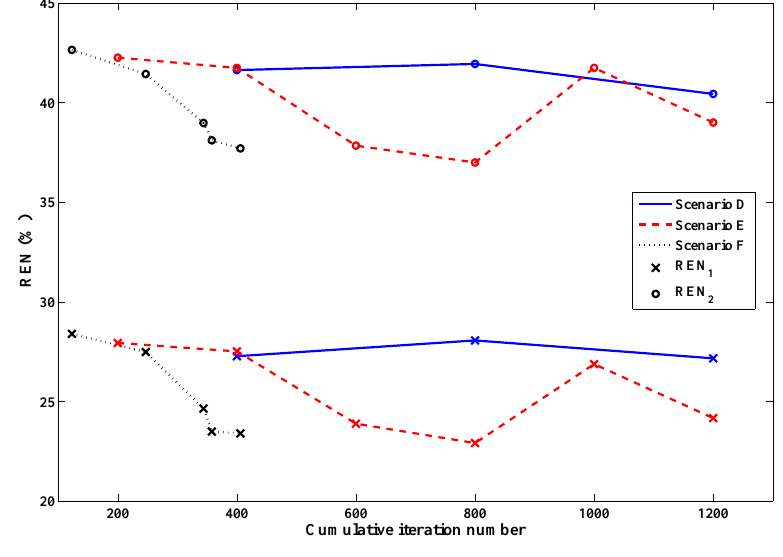
Relative error norms of reconstructions with PEC boundaries: Scenario D (solid line)—without tissue-dependent mapping at 400 iterations per frequency terminating after first inversion of 1.5 GHz data, Scenario E (dashed line)—with tissue-dependent mapping at 200 iterations per frequency, cycling through reconstruction frequencies once (with imaginary component “anchored” following initial 1.0 GHz inversion), Scenario F (dotted line)—with tissue-dependent mapping and stopping criteria in place, terminating after two consecutive inversions of 1.0 GHz data (one with the imaginary component “anchored” and the final run with the imaginary component freely optimized according to the guidelines of Section 2.5). See Table 2 for further